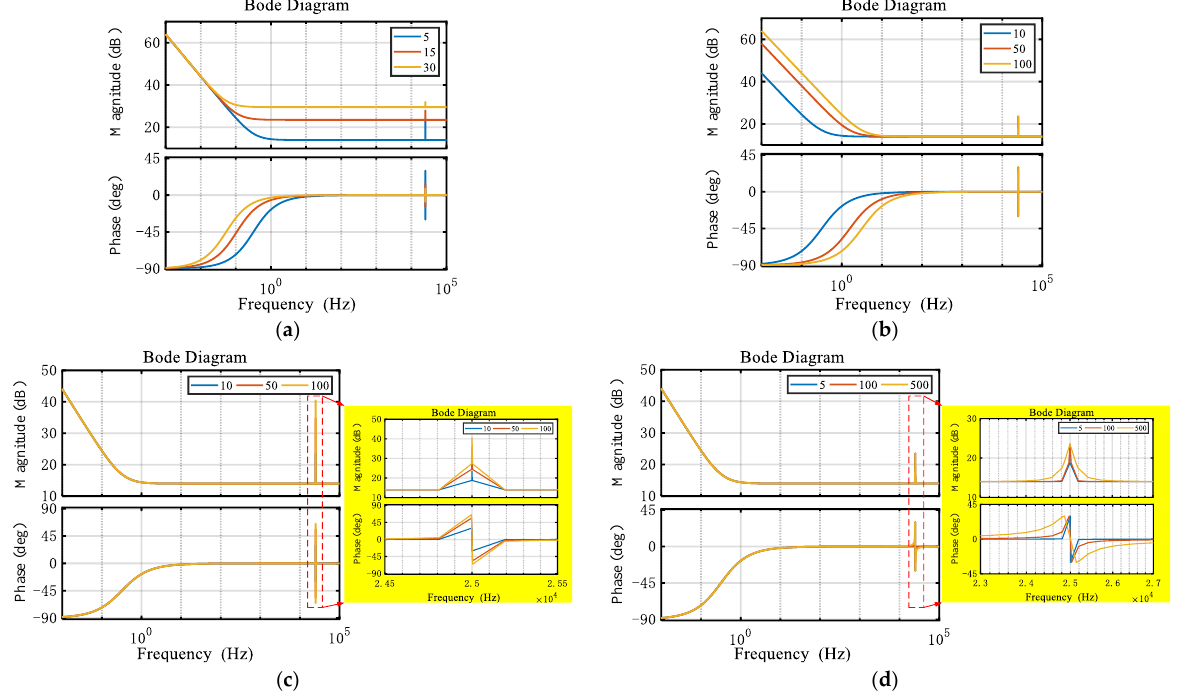
Figure 9. Bode diagram of PIR controller with different parameters: ( a ) k p change; ( b ) k i change; ( c ) k r change; ( d ) ω c change.